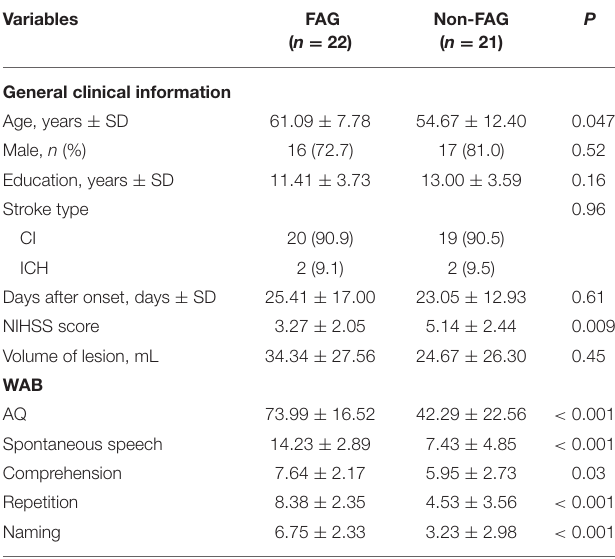
TABLE 4 | Comparison of general characteristics and WAB or LOTCA scores between fluent aphasia and non-fluent aphasia patients.